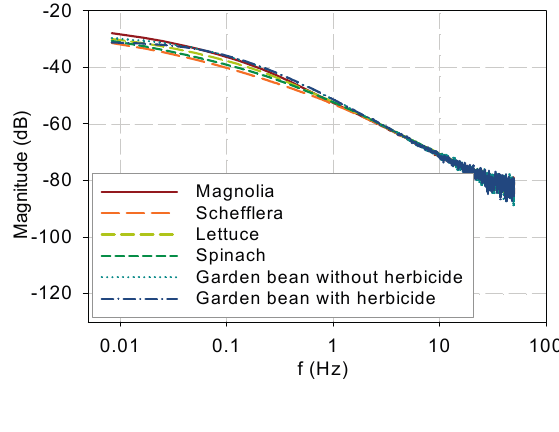
Figure 7. DF spectra of all the measured tree and vegetable